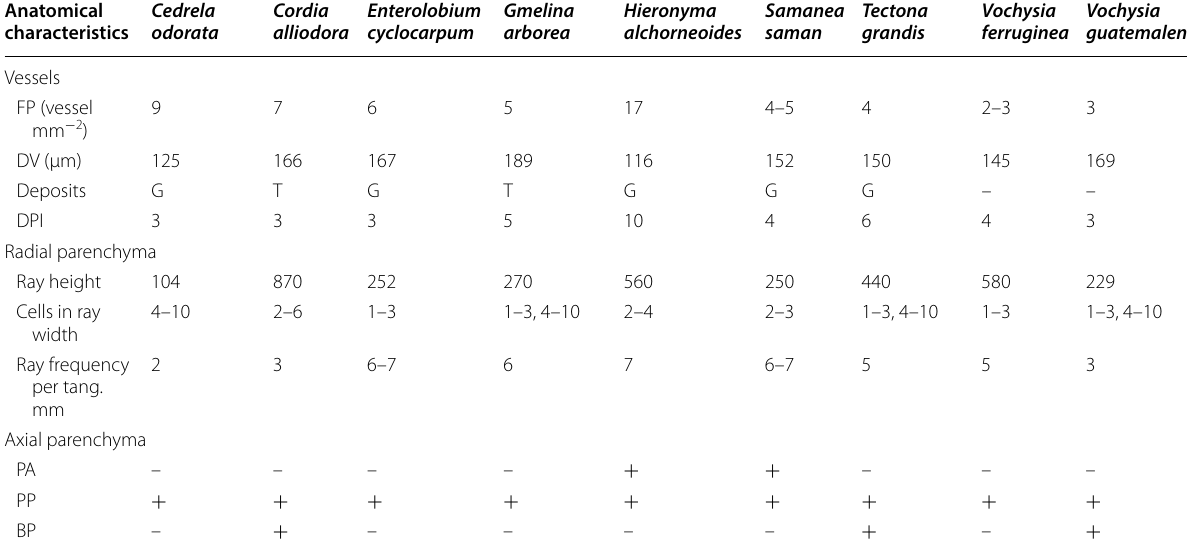
Table 3 Wood anatomical characteristics related to acetylation solution flow of nine tropical hardwood species in Costa Rica